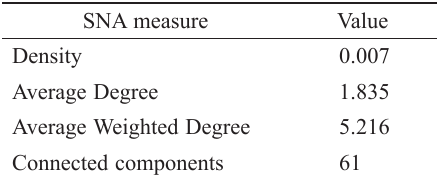
Table 1. Network level measures for the general network